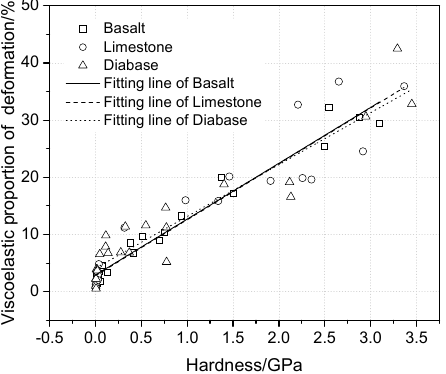
Figure 10. The relationship between viscoelastic proportion of deformation and hardness.